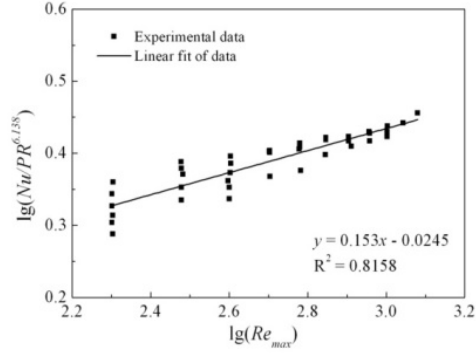
Figure 14. Determination of coefficient b .